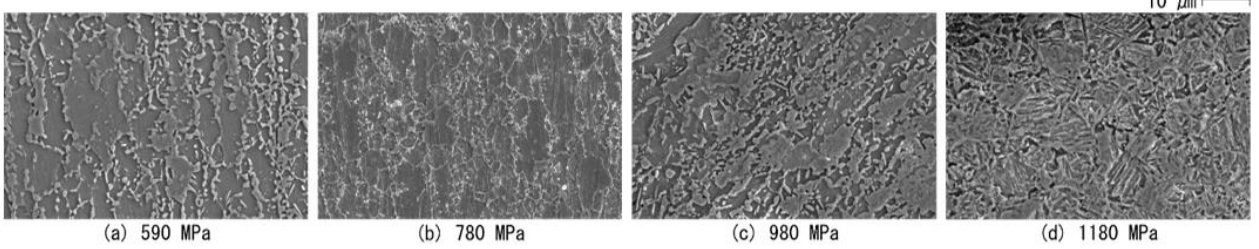
Figure 6. Relationship of maximum magnetic flux density of the sheets and magnetic flux density of magnet used for magnetization. The magnetic flux density distributions before and after shearing of the 1180 MPa steel sheet, magnetized and demagnetized, are shown in Figure 7. The magnetized blank was magnetized with the north pole on the right and the south pole on the left, corre- sponding to the magnet used for magnetization, and the maximum magnetic flux density was about 15 mT regardless of the poles. When the magnetized blank was sheared, the magnetic flux density distribution was maintained, but the maximum flux density became smaller. In the demagnetized blank, the magnetic flux density distribution became ran- dom, and the maximum flux density became less than 0.5 mT. When the demagnetized blank was sheared, the flux density distribution remained as irregular as before, but the flux density increased at the corners.